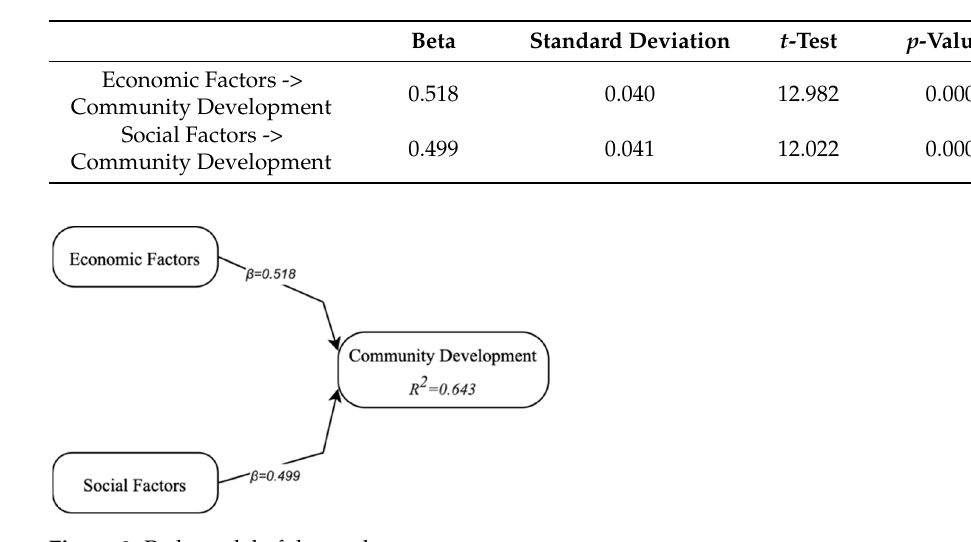
Table 6. Path coefficient of the model.